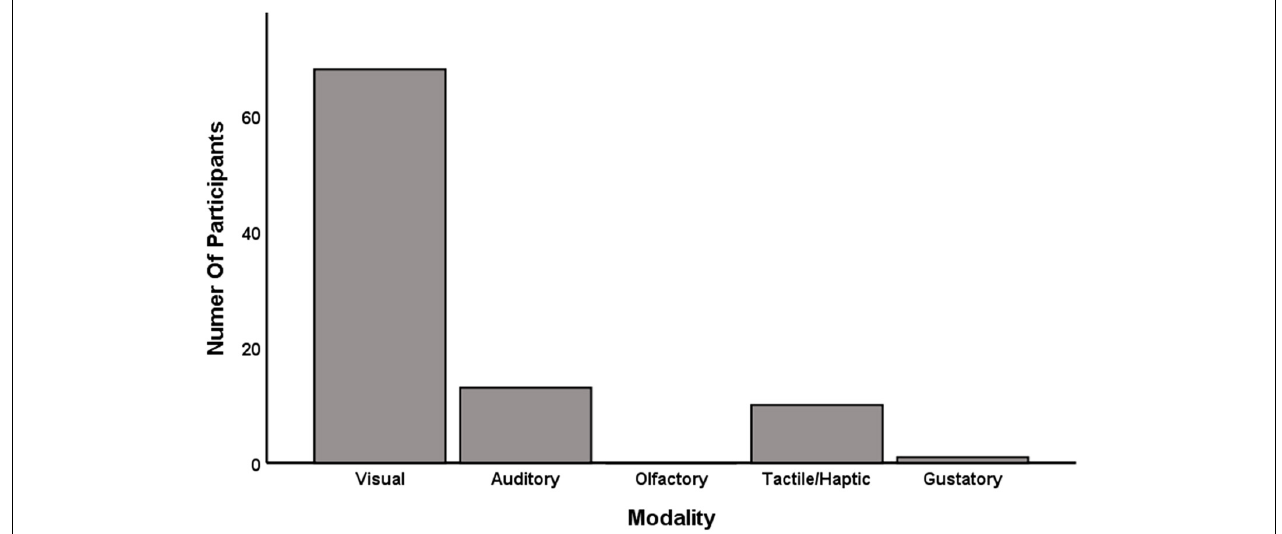
FIGURE 2 | Participants of an online-survey ( N = 91) were asked to answer the following question: “Losing which modality does scare you the most?” The response options were presented in random order (see Supplementary Data Sheet 2